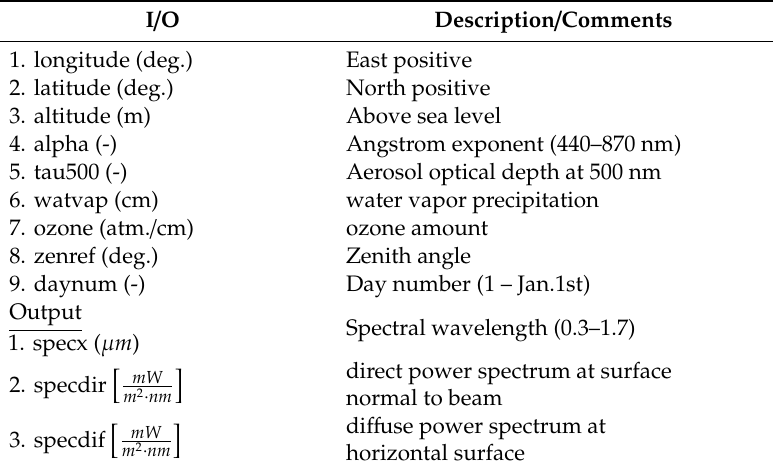
Table 1. SPECTRAL(2) interface.